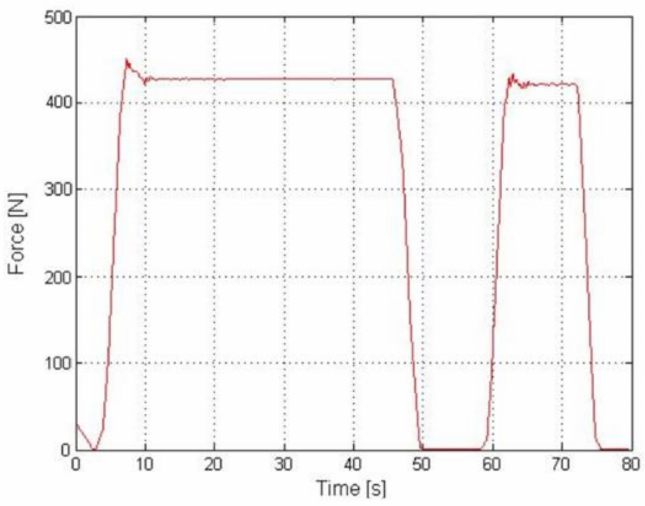
Figure 15. Strain gauge force measurement result during the Z axis